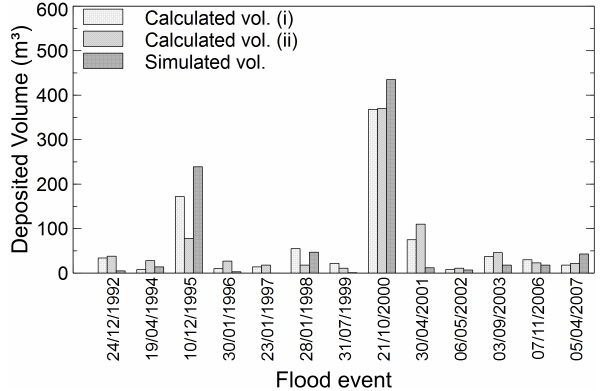
Fig. 12. Sediment temporal validation with the second calibration sediment parameter set: 13 events (out of 38 modelled flood events) were associated to the 15 detected flood units. The surface gravel body was not considered. Notice that model was calibrated using the sum of sedimentation volumes from 1 to 15.